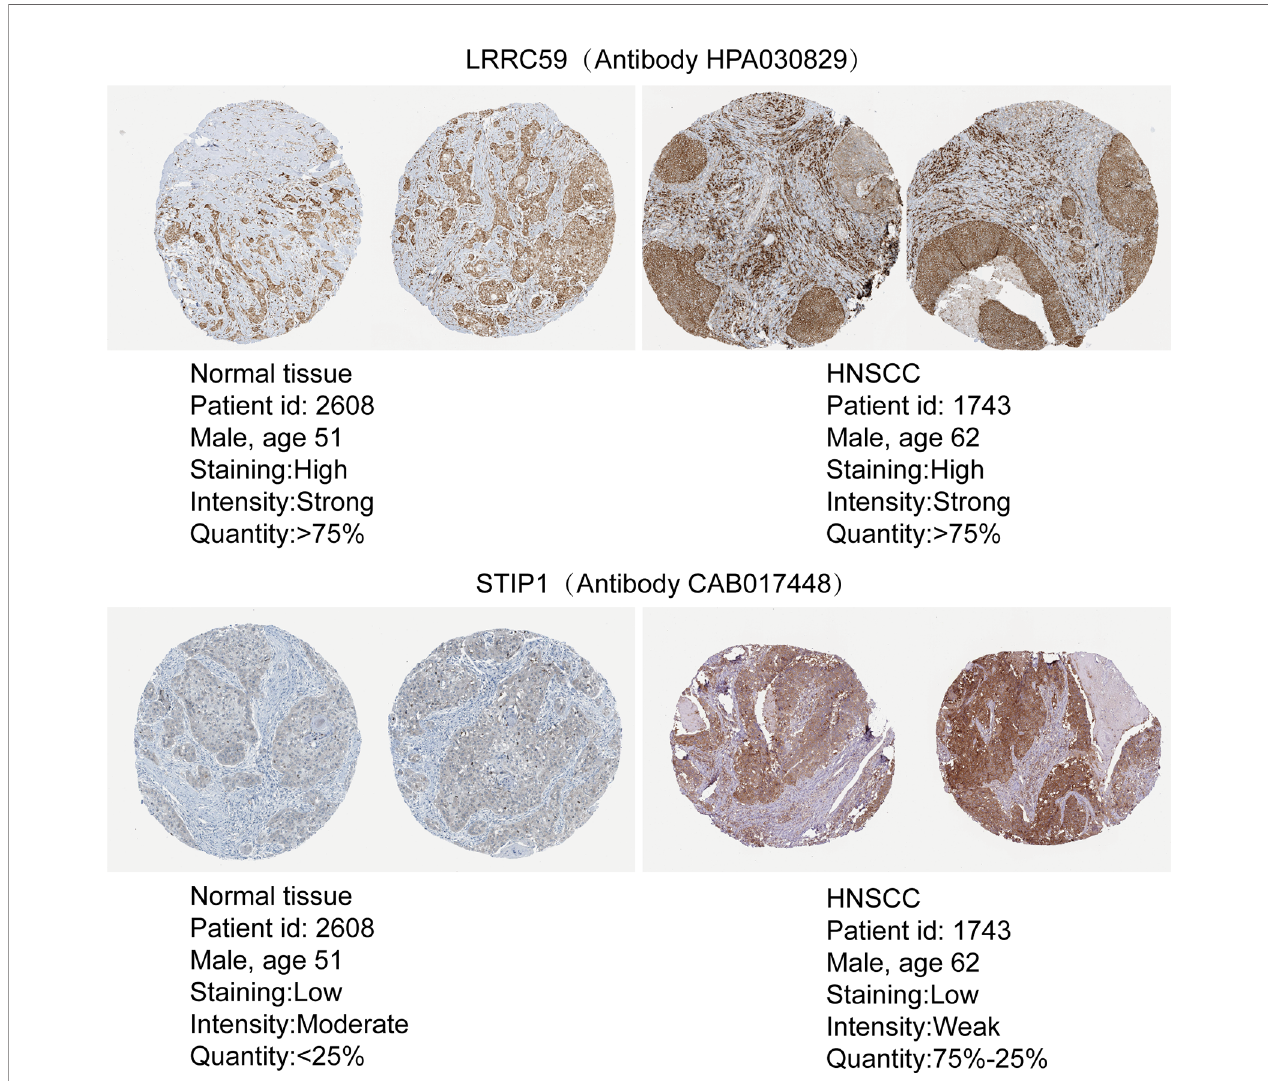
FIGURE 8 | The protein expression of m 6 A target genes. A Comparison of the protein expression of LRRC59 and STIP1 in HNSCC tumor tissues and normal